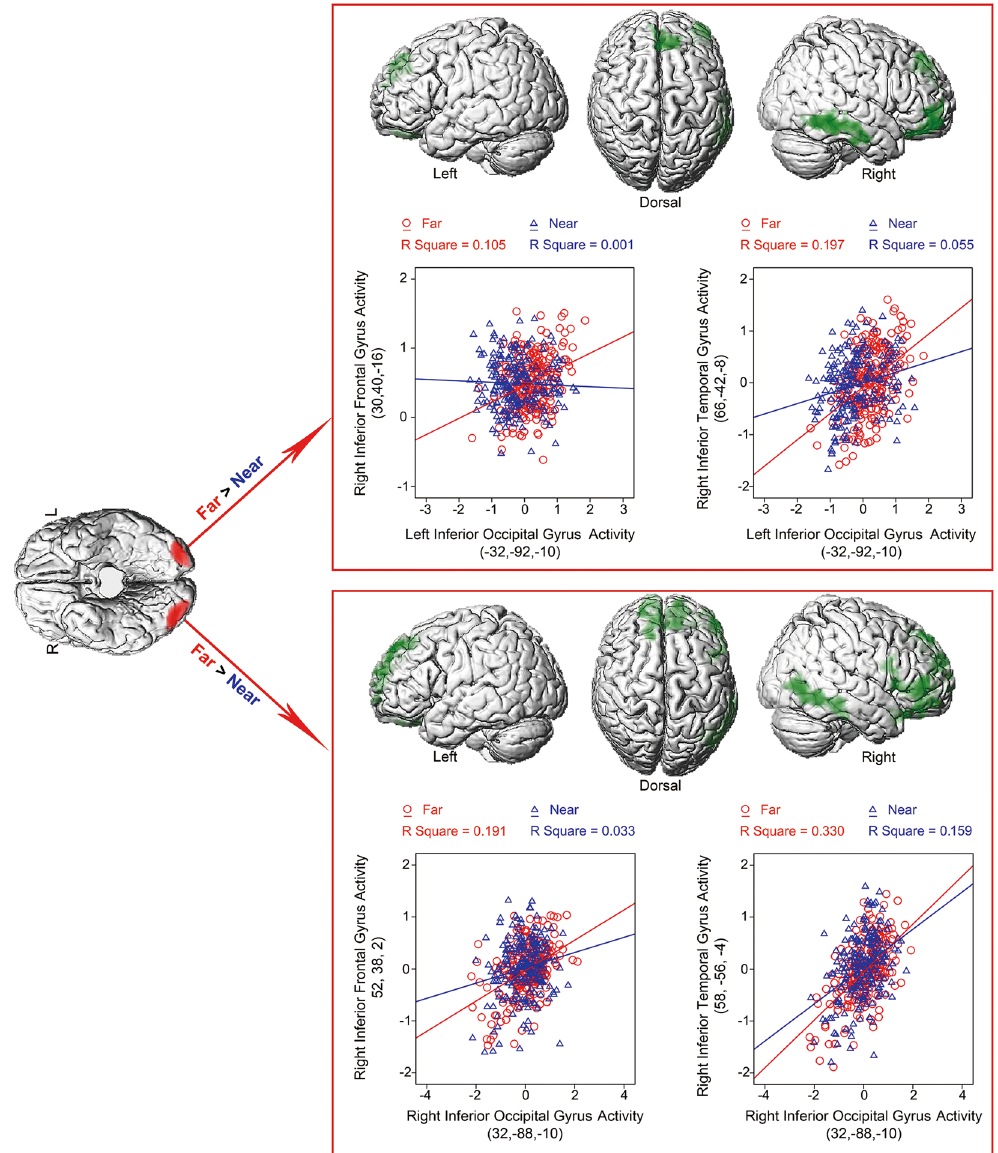
Figure 3. PPI analysis based on neural activity in bilateral IOG (red) with the “Far > Near” contrast as the psychological factor in the virtual 3D experiment. The right upper panel: the left IOG showed higher neural coupling with the right IFG, the right SFG and the right ITG in the “Far” condition than in the “Near” condition. PPI analysis based on neural activity in the left IOG (Subject 3D_S13) was shown. Mean corrected neural activity in the right IFG and the right ITG was plotted as a function of the mean corrected activity in the left IOG in the “Far” and “Near” conditions, respectively. The right lower panel: the right IOG showed higher neural coupling with the right IFG, the right SFG and the right ITG in the “Far” condition than in the “Near” condition. PPI analysis based on neural activity in the right IOG (Subject 3D_S13) was shown. Mean corrected neural activity in the right IFG and the right ITG was plotted as a function of the mean corrected activity in the right IOG in the “Far” and “Near” conditions,